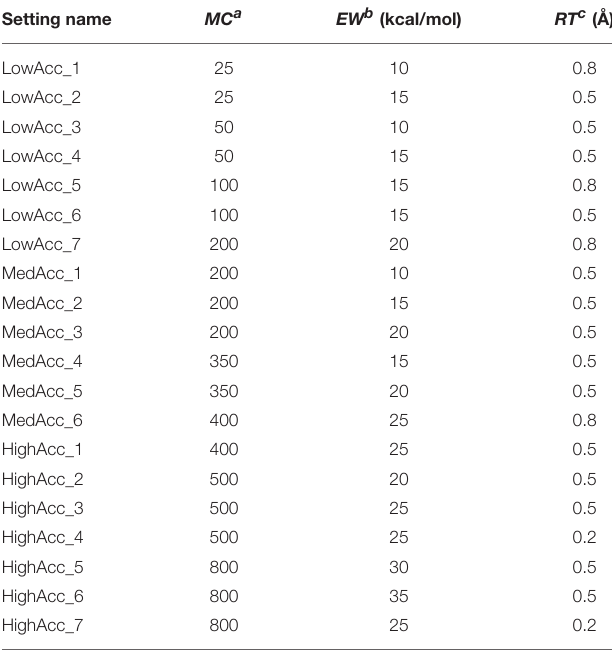
TABLE 1 | Setting patterns tested for conformer generation with iCon and